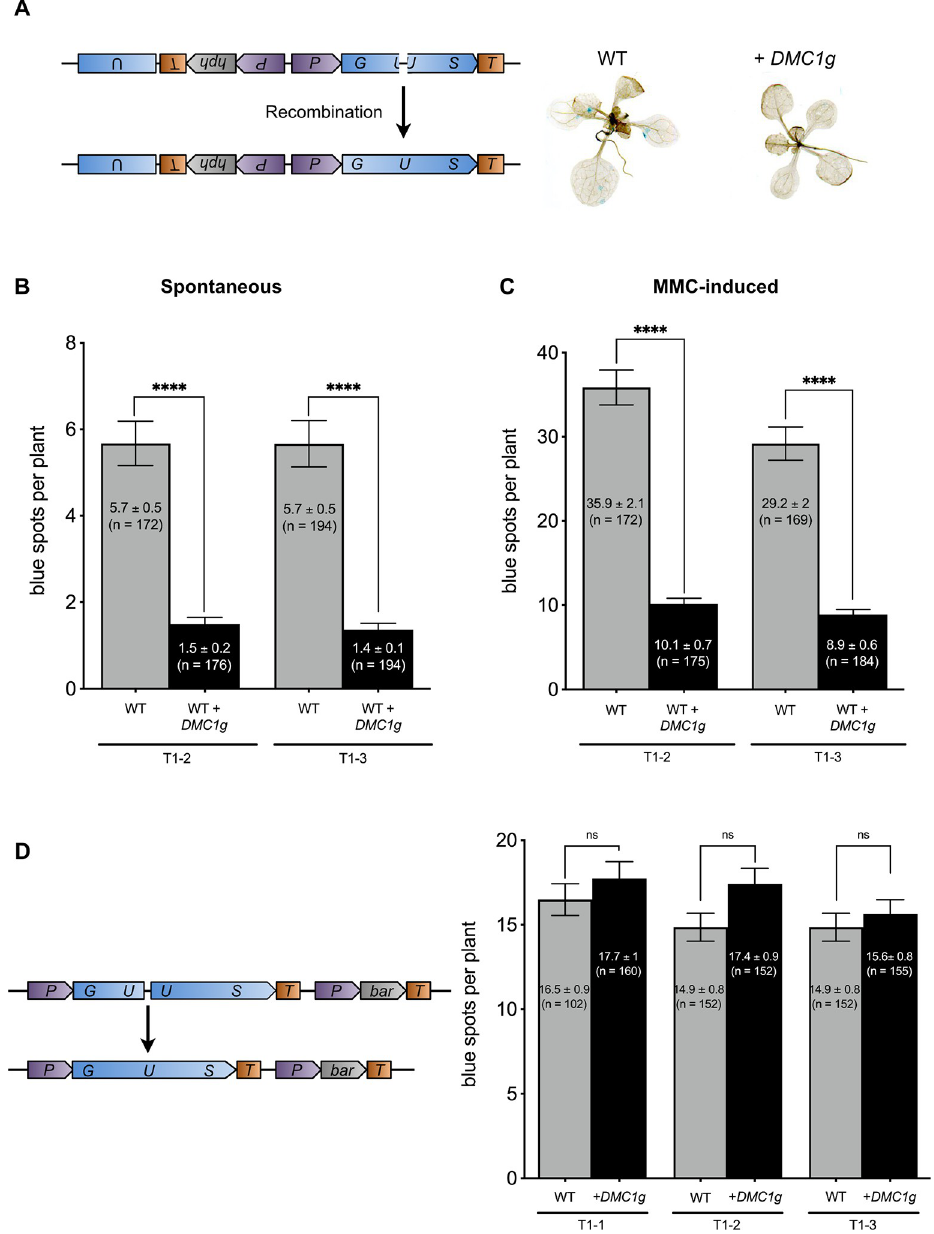
Fig 3. DMC1 inhibits RAD51-dependent somatic homologous recombination. (A) Schematic map of the IU . GUS chromosomal recombination reporter locus. Restoration of the functional GUS gene is visualized as blue spots in seedlings. Both spontaneous (B) and MMC induced (C) IU . GUS recombination rates are strongly reduced in wild-type seedlings expressing pRAD51 :: DMC1g . Mean numbers of GUS+ recombinant spots per plant ± standard errors of the means (SEM) are indicated for each genotype (n = 3, N > 45 seedlings). ���� p < 0.0001 (Mann-Whitney test). The wild-type plants with and without pRAD51 :: DMC1g are sister plants from a transgenic line segregating for the pRAD51 :: DMC1g transgene. Analysis were performed using segregating plants from two independent transgenic lines (T1-2 and T1-3). (D) Schematic map of the GU . US chromosomal recombination assay and graph showing mean numbers of GUS+ recombinant spots per plant ± SEM. Three independent GU.US transformants expressing pRAD51 :: DMC1g (T1-1, T1-2, T1-3) and 2 WT (sister plants from a population segregating the pRAD51 :: DMC1g transgene) were analyzed (WT for T1-3 is the same as for T1-2). Three biological replicates, each containing at least 50 plants, were performed, except for the WT T1-1 for which only two replicates were performed. ns indicates p > 0.05 (Mann- Whitney test).